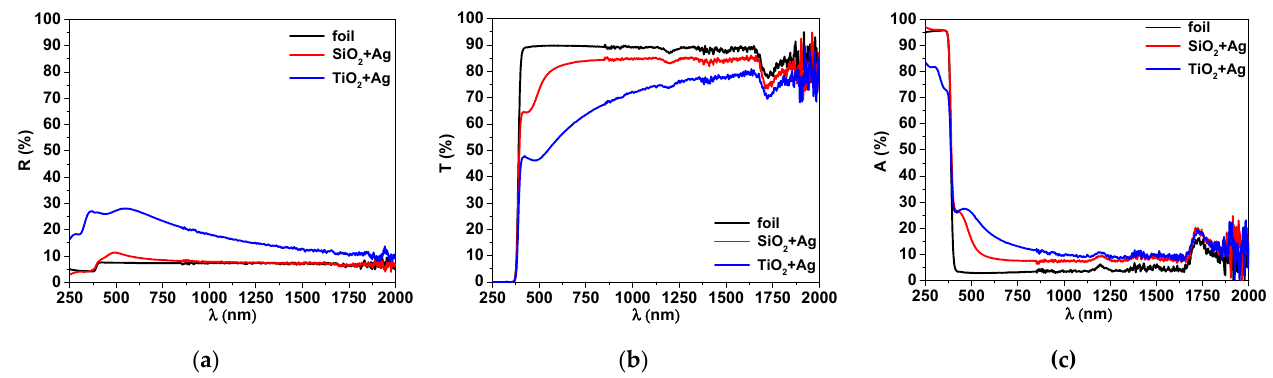
Figure 1. Spectrophotometric curves, reflectivity ( a ), transmittance ( b ) and absorbance ( c ) of the uncoated foil and the foils coated with SiO 2 + Ag, TiO 2 + Ag.